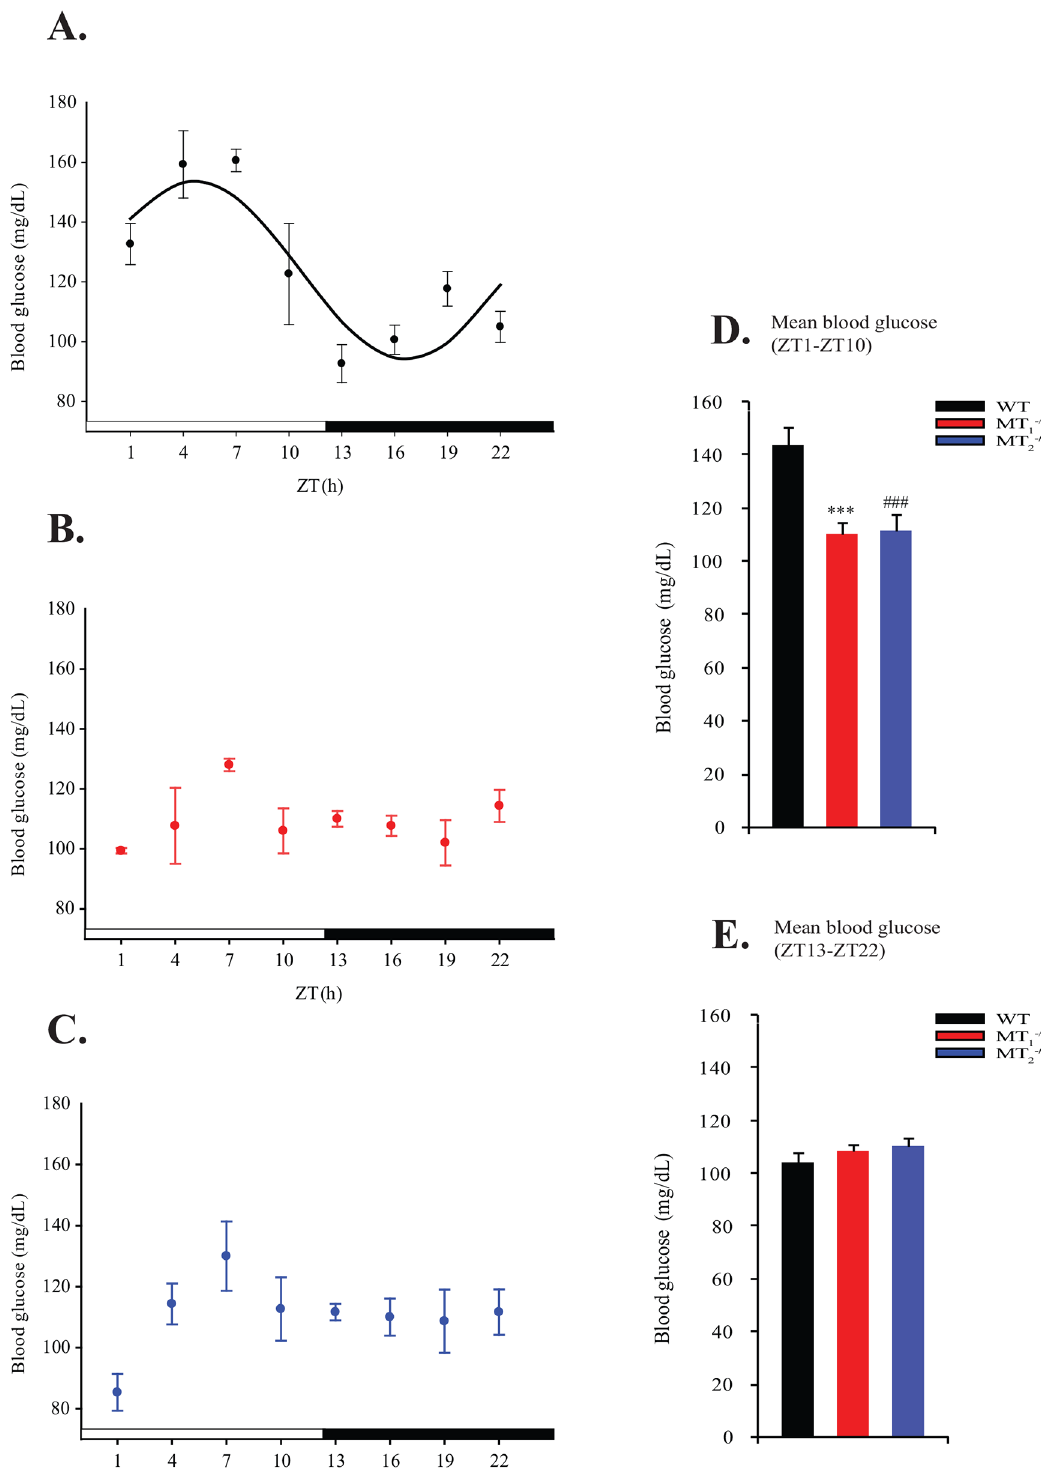
Fig 1. Loss of melatonin receptors disrupts daily rhythms in blood glucose. Blood glucose levels every 3 hours across the light/dark cycle in WT (A), MT 1-/- (B) and MT 2-/- (C) mice fed ad libitum are denoted within each respective plot. Results are expressed as mean ± SEM in which the black solid line in (A) represents the periodic sinusoidal function of the blood glucose rhythm as determined by COSINOR analysis (p < 0.05, (N = 3 – 4 for each time point and